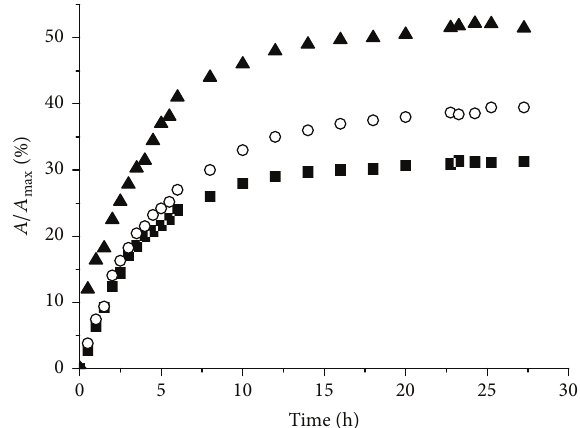
Figure 3: Determination of the Pt released from 3 - DS in 0.5x (black squares), 1x (white circles), and 2x PBS (black triangles) solutions (pH = 7.4), at different times. 𝐴 = absorbance of the solution at differenttimepoints( 𝜆 max =308 nm); 𝐴 max =theoreticalabsorbance of the solution considering a complete release of the loaded Pt